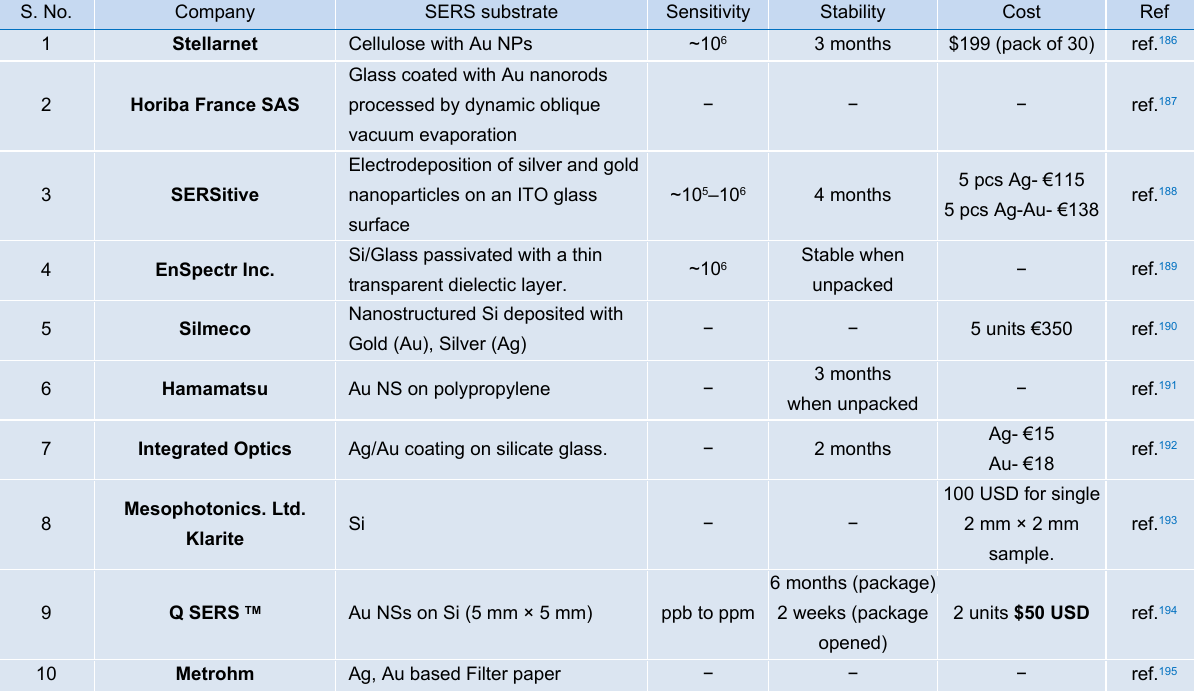
Table 3 | A summary of the commercially available SERS substrates, their costs, sensitivities and their stability (non-exhaustive). S.